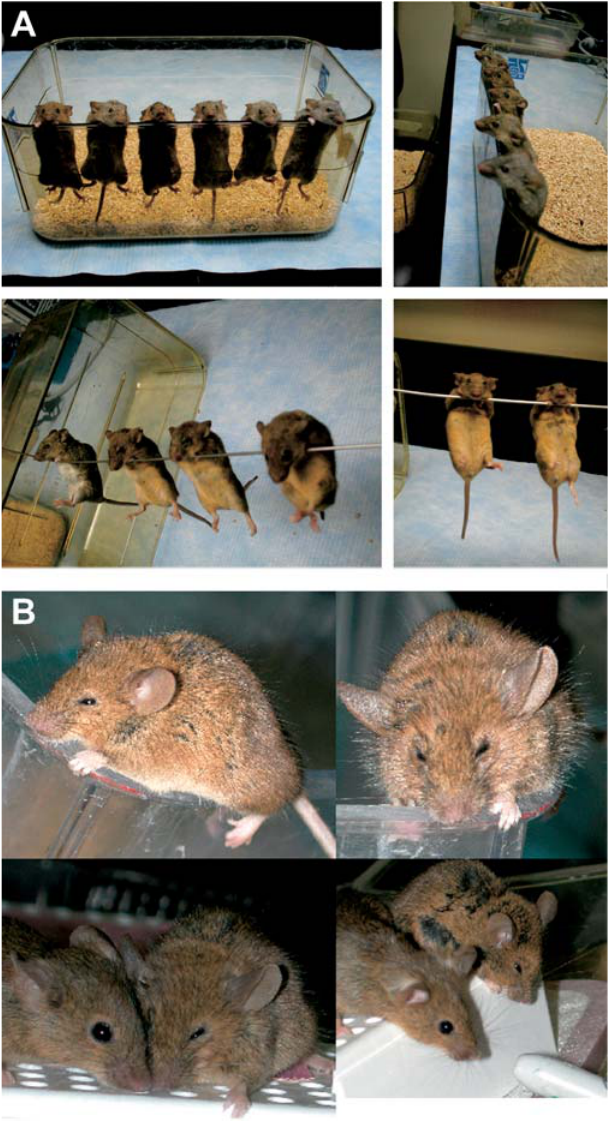
Figure 2. Display of Behavioral Phenotypes of DDD Mice (A) Akinesia and rigidity of DDD mice. Photos were taken 30 min after treatment of DAT-KO mice with a MT (250 mg/kg IP). (B) Ptosis in DDD mice. Photos were taken 3 h after treatment of DAT-KO mice with a MT (250 mg/kg IP). Lower panel: Mouse on the left side is saline-treated DAT-KO mouse, whereas the mouse on the right side is a MT-treated DAT-KO mouse. DOI: 10.1371/journal.pbio.0030271.g002